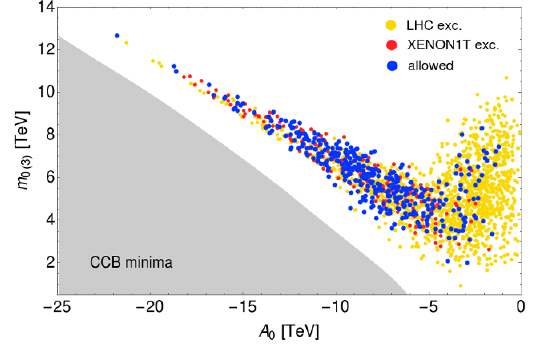
(b) LHC Run 2 limit for m ~ g > 2 : 25 TeV is shown by the red contour. vs. m 0 (3) 1 = 2